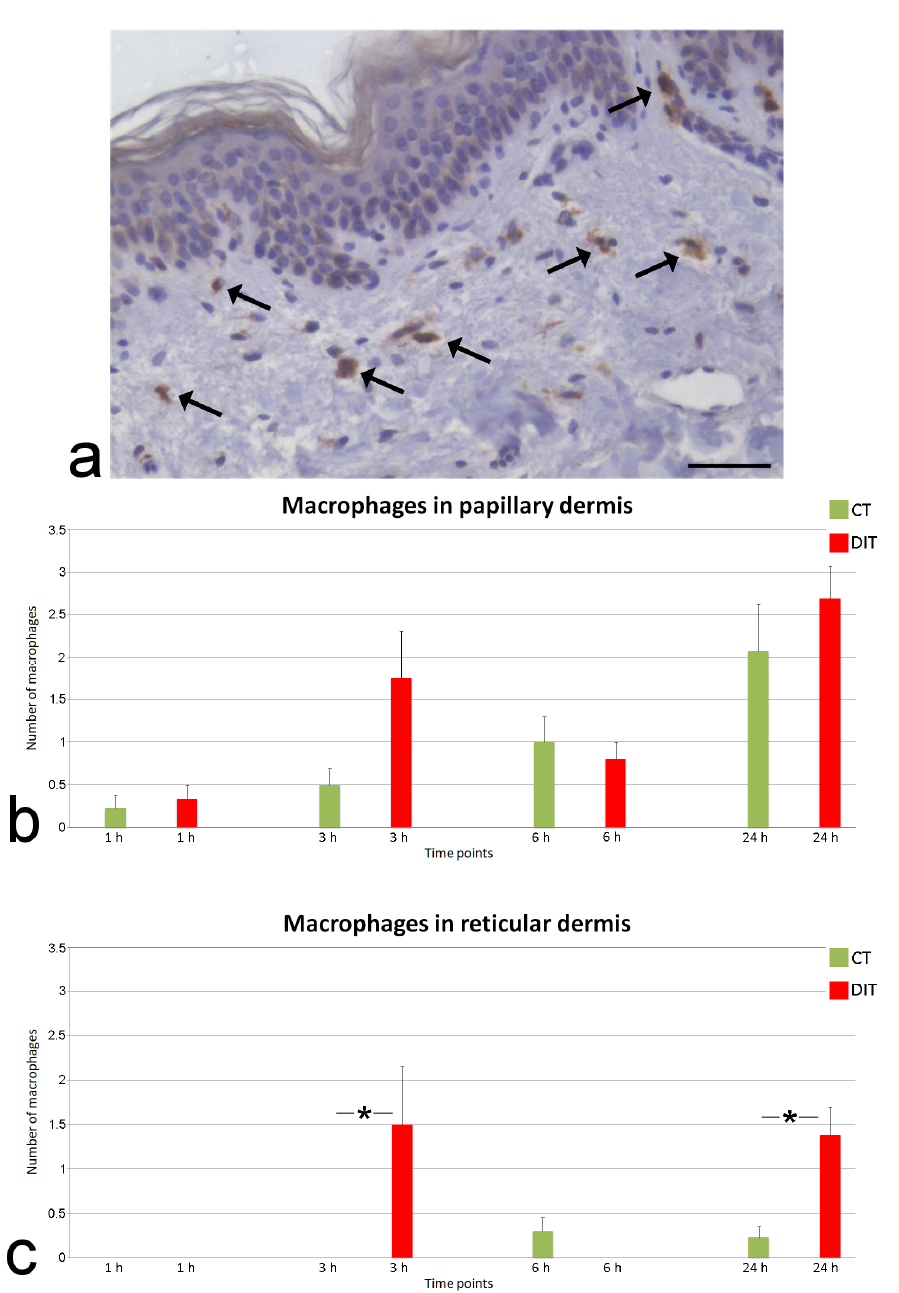
Figure 6. ( a ) Skin sample treated with dithranol for 24 h and immunolabelled with anti-CD68 antibody. Labeled macrophages are indicated by arrows. Bar: 50 µ m. ( b , c ) Mean ± standard error values of macrophage number in papillary ( b ) and reticular ( c ) dermis. Asterisks indicate significant difference (3 h CT vs. 3 h DIT, p = 0.032; 24 h CT vs. 24 h DIT, p = 0.003). CT, control (untreated); DIT, dithranol-treated.